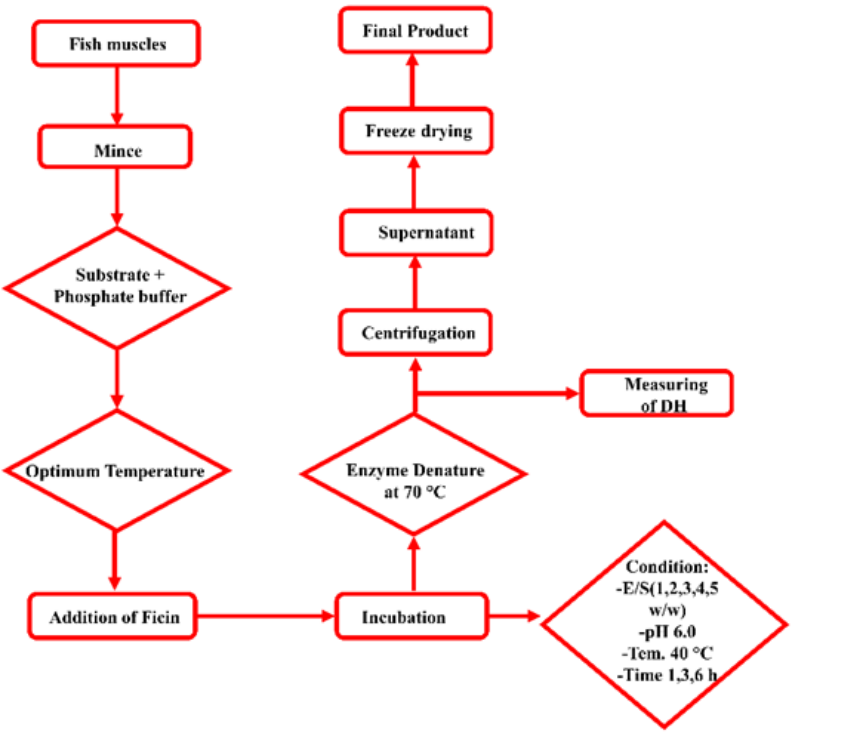
Figure 1. Scheme of hydrolysate production from bighead carp using ficin enzyme.